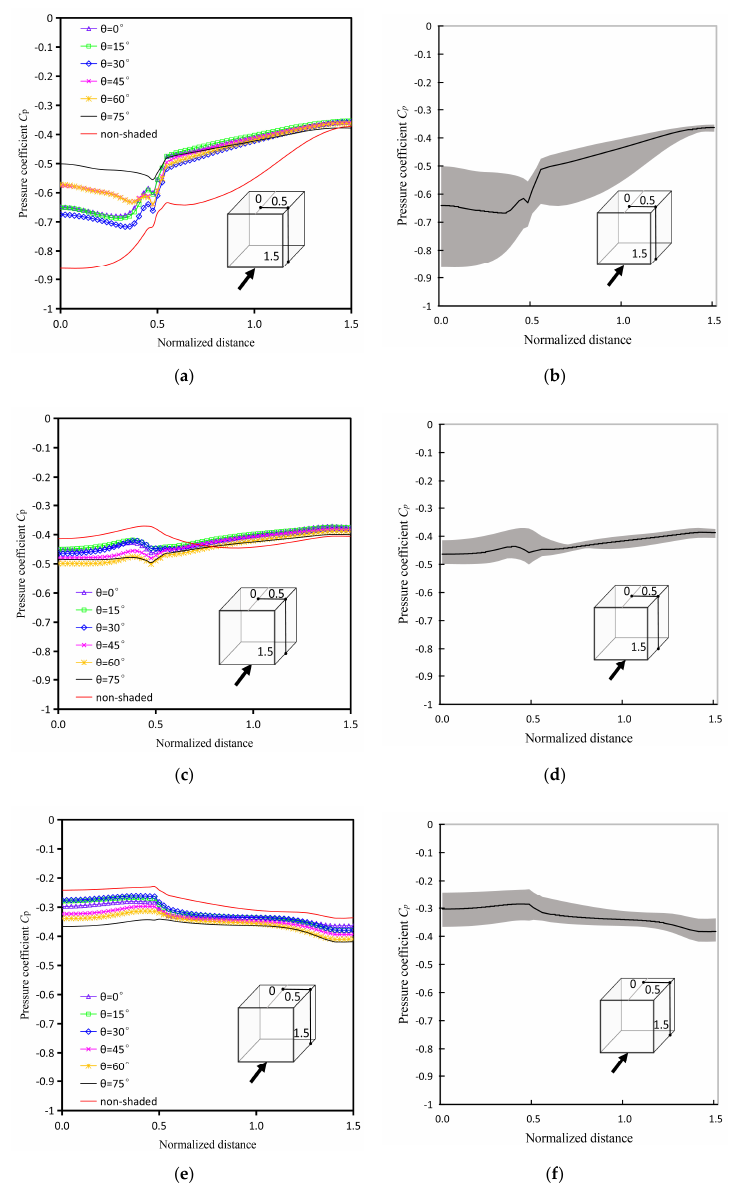
Figure 14. Local range R , local and average value of wind pressure coe ffi cient C p for di ff erent shaded conditions on the central lines of di ff erent rows along the roof and lateral surfaces. ( a ) Local value along R3; ( b ) Local range R and average value along R3; ( c ) Local value along R4; ( d ) Local range R and average value along R4; ( e ) Local value along R5; ( f ) Local range R and average value along